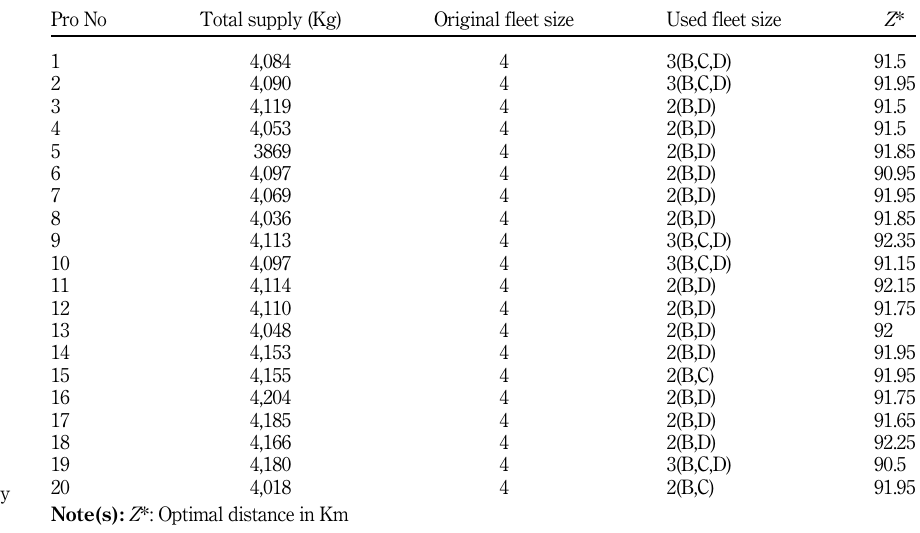
Table 4. Obtained results by CPLEX